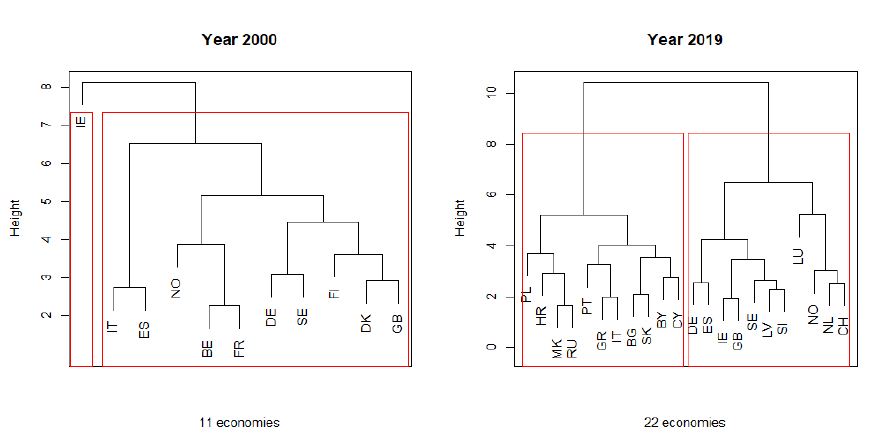
Figure 4. Dendrograms for the years 2000 and